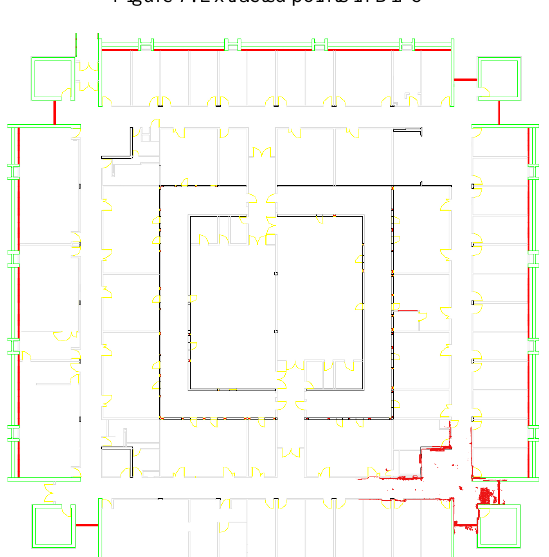
Figure 8. Overlay of the registered PC on the CAD by